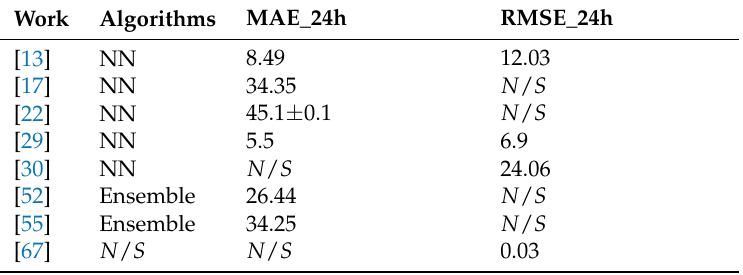
Table 3. PM 2.5 prediction accuracy for the next 24 h measured by mean absolute error (MAE) and root mean square error (RMSE). N / S : Not